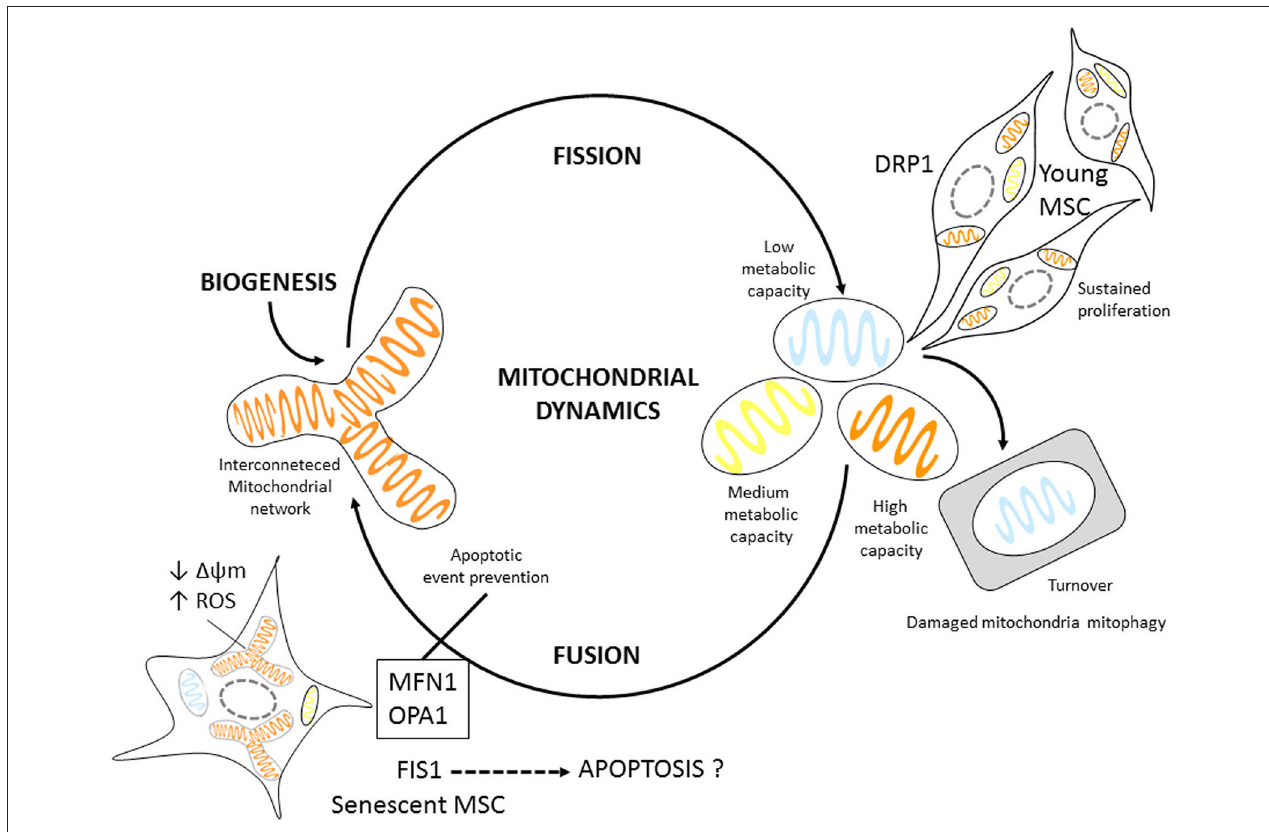
FIGURE 6 | Mitochondrial dynamic Model proposal for MSCs. Young MSCs can readily undergo proliferation. Mitotic cells have slightly higher DRP1 expression, possibly regulating mitochondrial fission. Senescent MSCs display mitochondrial fusion. In addition they have larger mitochondrial volume; express proteins associated with fusion events most likely as an adaptation mechanism to energetic changes, such as increased ROS production, and decreased 1 ψ m possibly to prevent